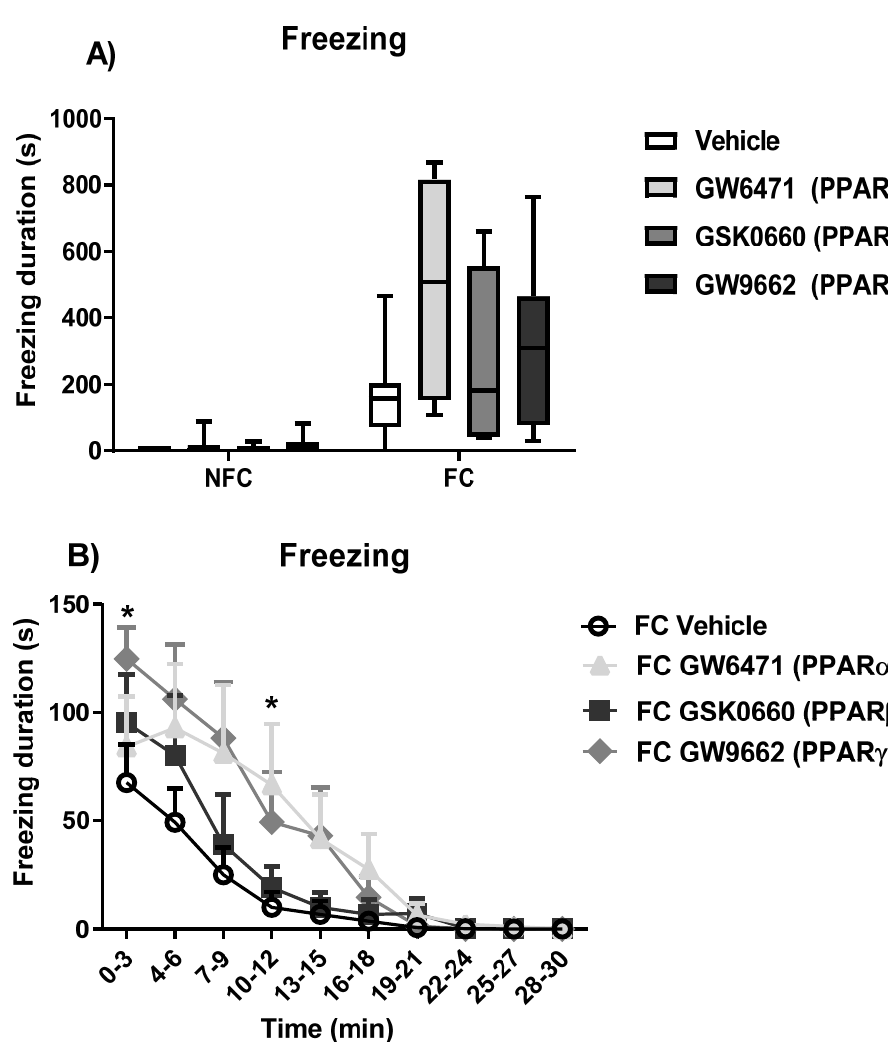
Figure 3. Effects of intra-BLA administration of selective PPAR α , PPAR β / δ , and PPAR γ antagonists on freezing duration over the total trial period ( A ) and as 3-min time bins ( B ) in non-fear conditioned (NFC) and fear conditioned (FC) rats. Post hoc analysis indicated a significant increase at 0–3 min for FC GW9662-treated rats (* p < 0.05, vs. FC vehicle), and FC GW6471-treated rats at 10–12 min (* p < 0.05, vs. FC vehicle). Data are expressed as the median with interquartile range and min/max ( A ) and mean ± S.E.M. ( B ) ( n = 7–9 rats per group).